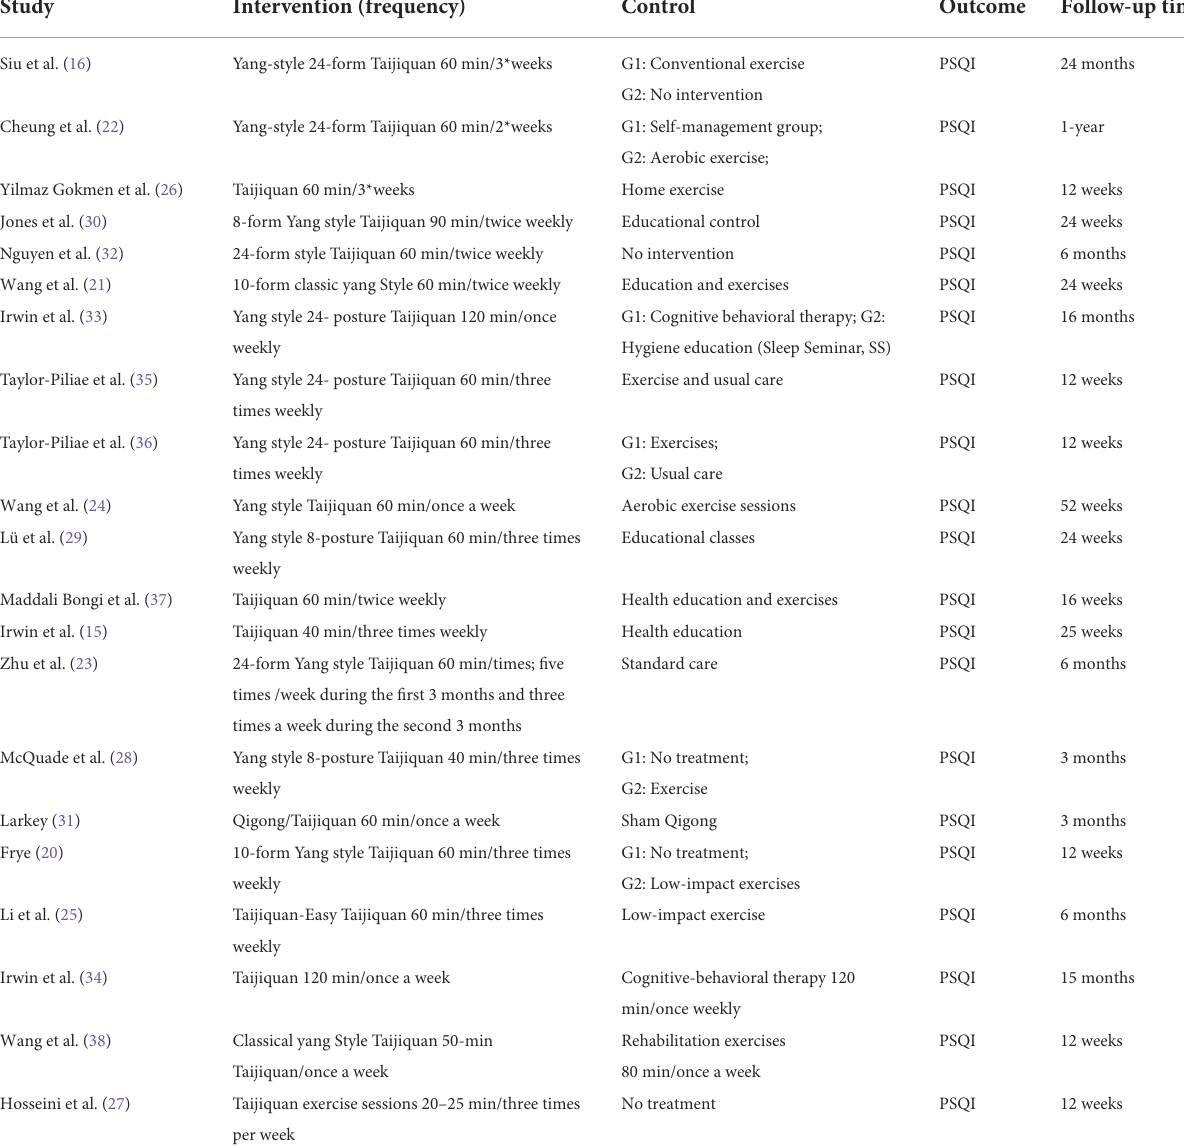
TABLE 3 Basic information included in the